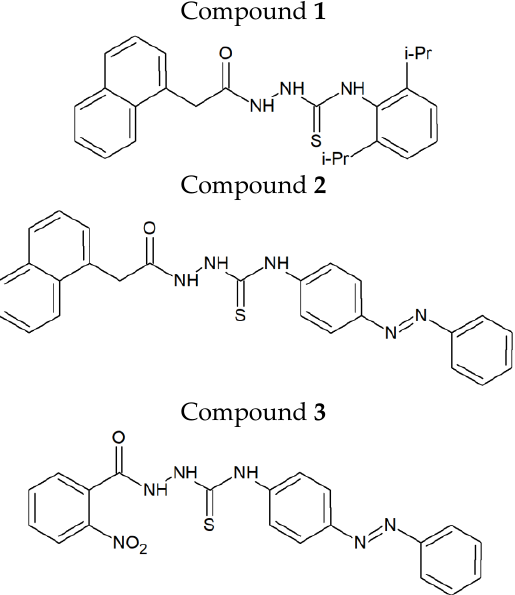
Figure 1. First in-class dual inhibitors targeting human topoisomerase II α and indoleamine-2,3-dioxygenase 1.